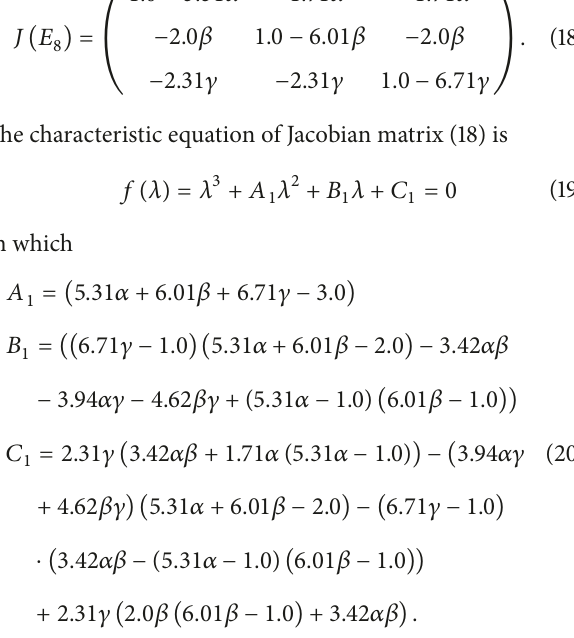
Its Jacobian matrix is (1.0 𝐽 (𝐸 ) = 8